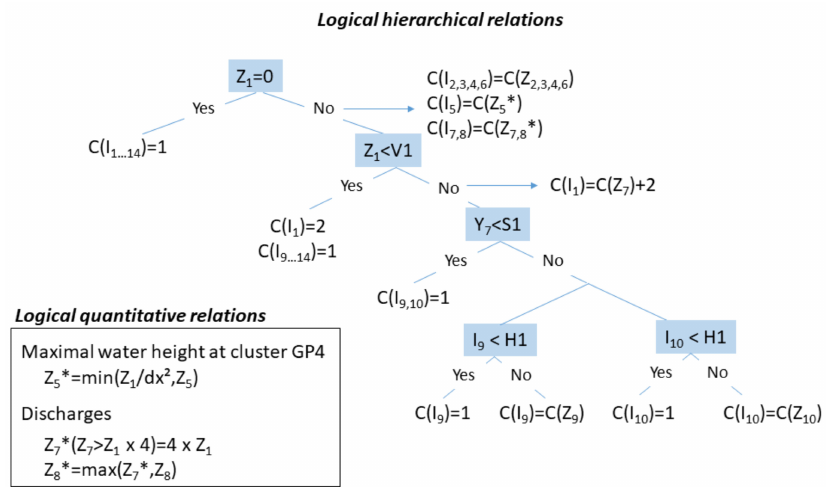
Figure 5. Logic tree to combine the different metamodel outputs Z k and construct the indicators I j , with C corresponding to the classification shown in Figure 3. The star symbol (*) indicates that a post-processing based on logical quantitative relations (see the box bottom left) is